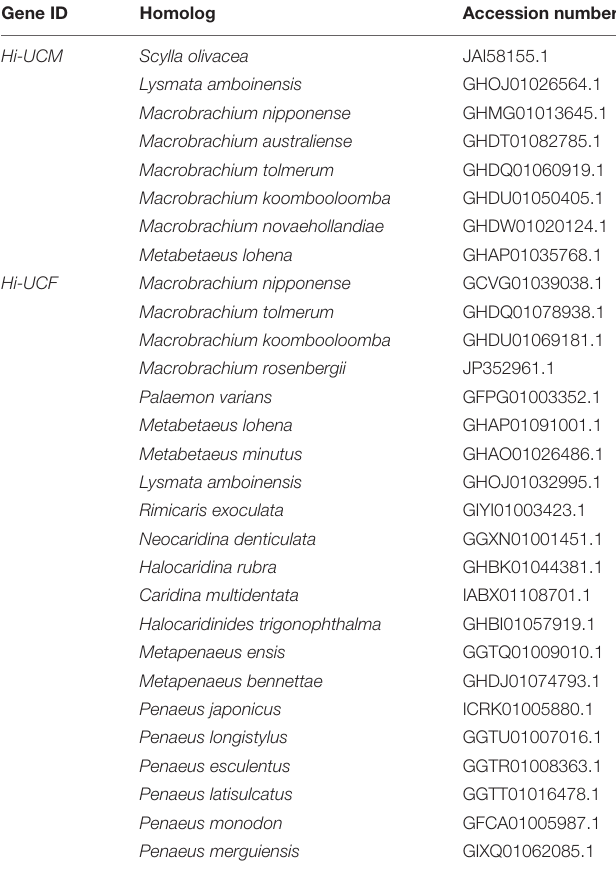
TABLE 3 | Homolog sequences of Hi-UCM and Hi-UCF in other decapod species found by blastx and tblastn in the NCBI server.